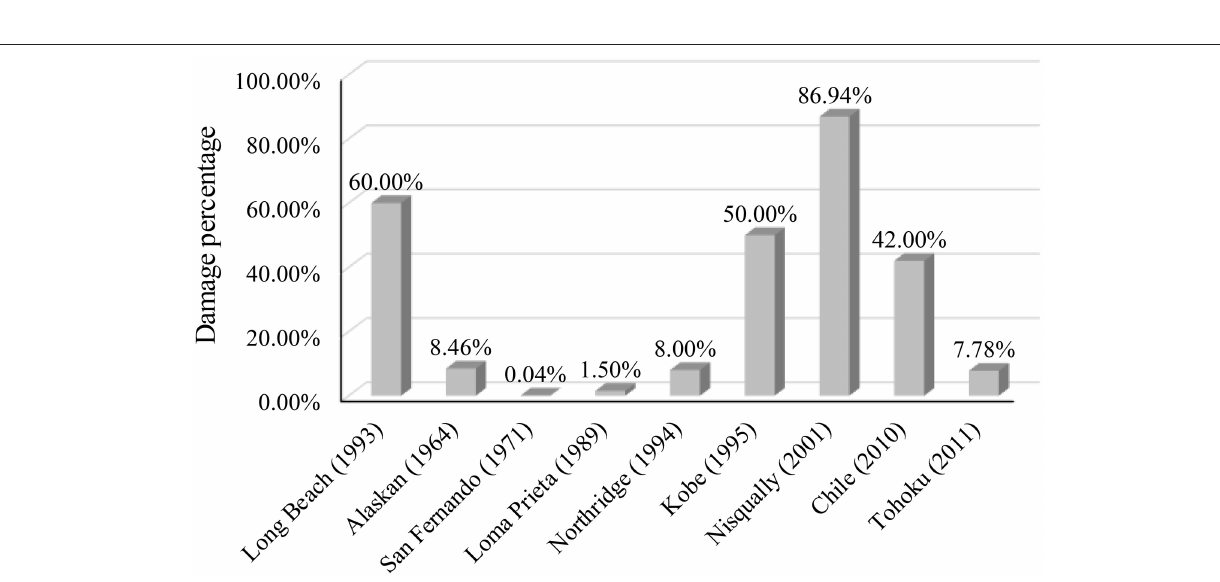
FIGURE 2 | Statistics of the damaged piping systems over all investigated piping